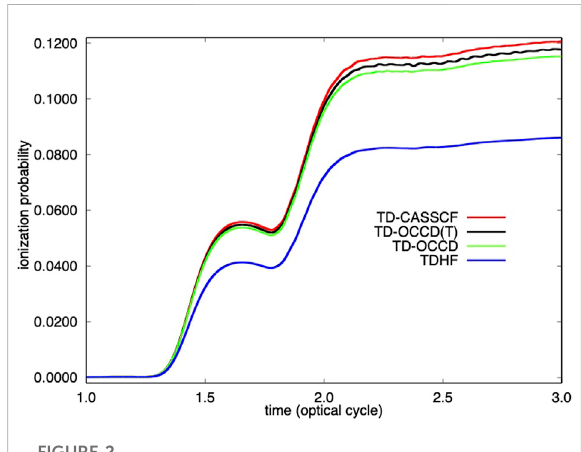
FIGURE 2 Time evolution of single ionization probability of Kr irradiated by a laser pulse with a wavelength of 800 nm and a peak intensity of2×10 14 W/cm 2 calculatedwithTDHF,TD-OCCD,TD-OCCD(T), and TD-CASSCF